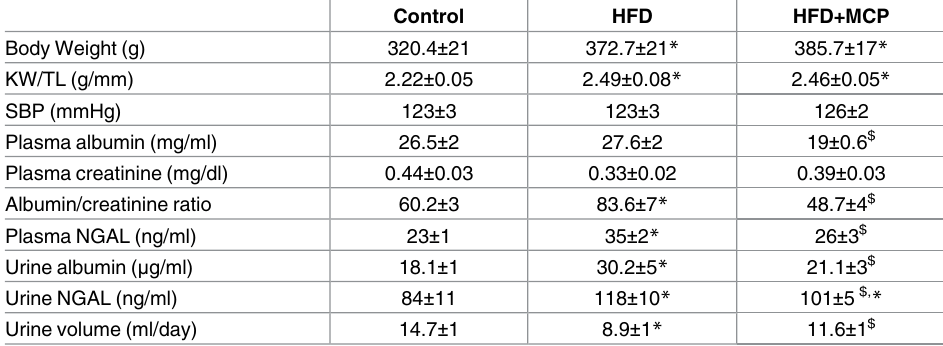
HFD: high fat diet; MCP: modified citrus pectin; KW: kidney weight; TL: tibia length; SBP: systolic blood pressure; NGAL: neutrophil gelatinase-associated lipocalin. Data values represent mean ± SEM of 8 animals. * p < 0.05 vs. Control group $ p < 0.05 vs . HFD